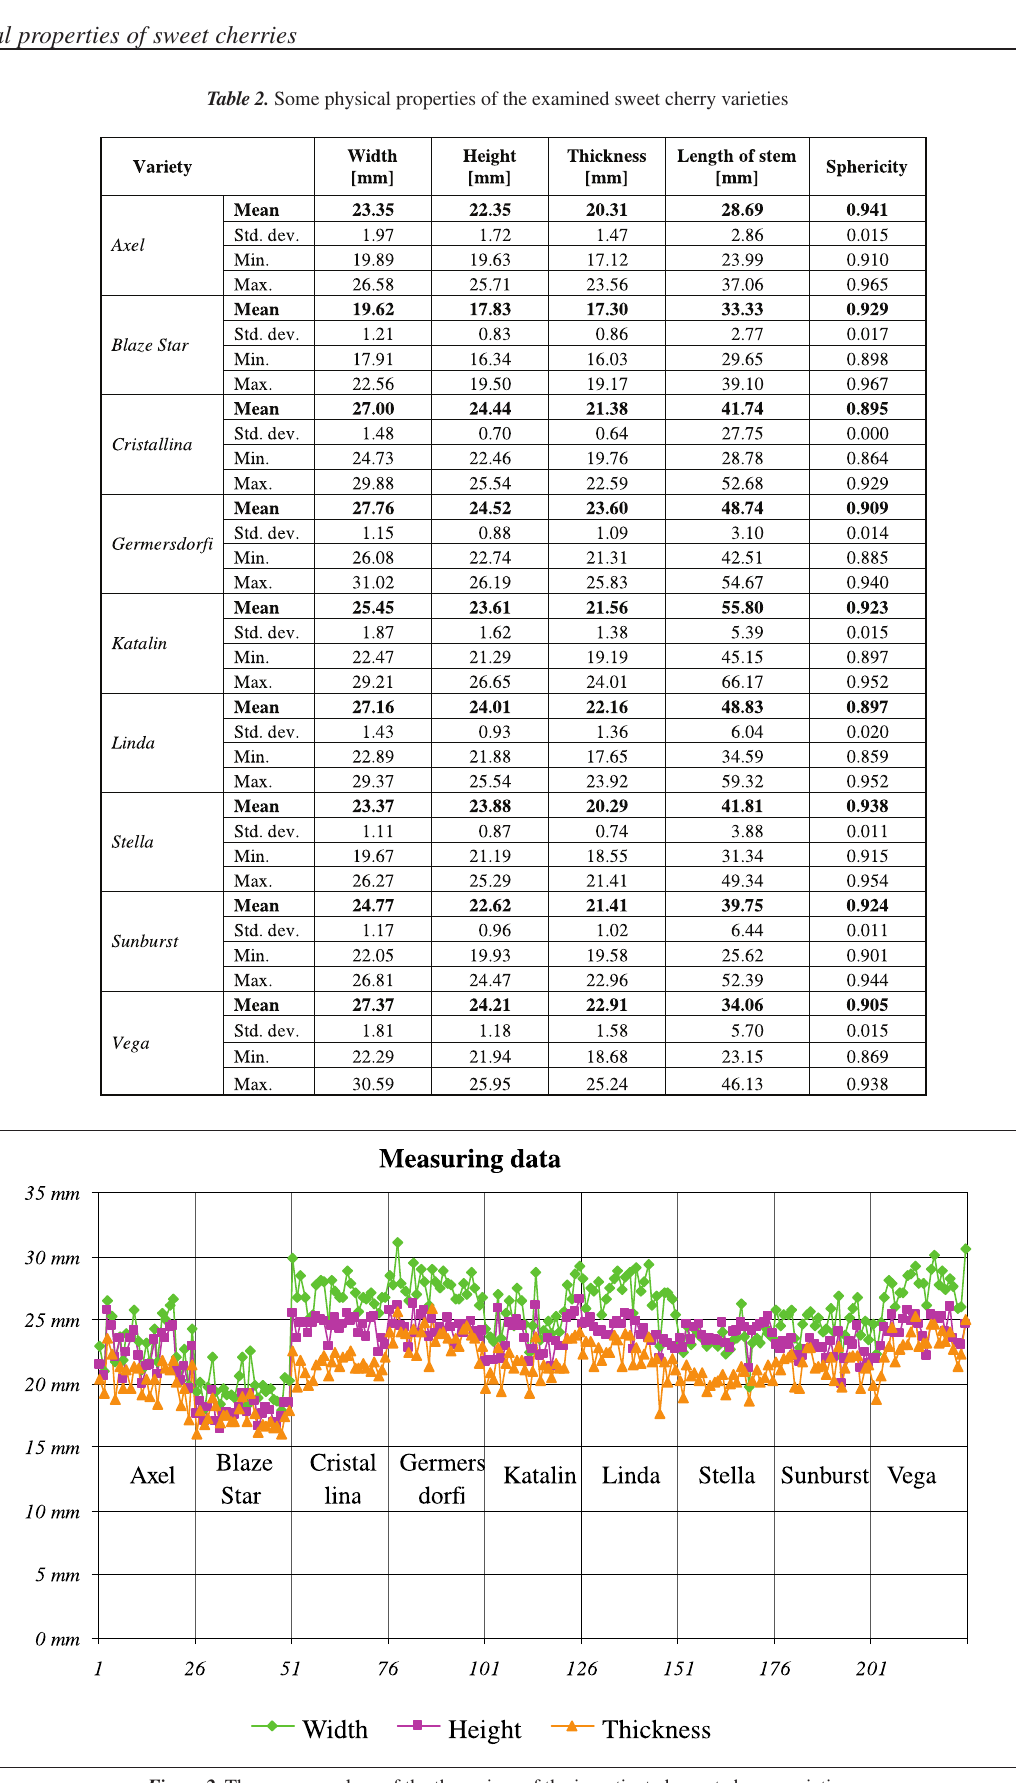
Figure 2. The average values of the three sizes of the investigated sweet cherry